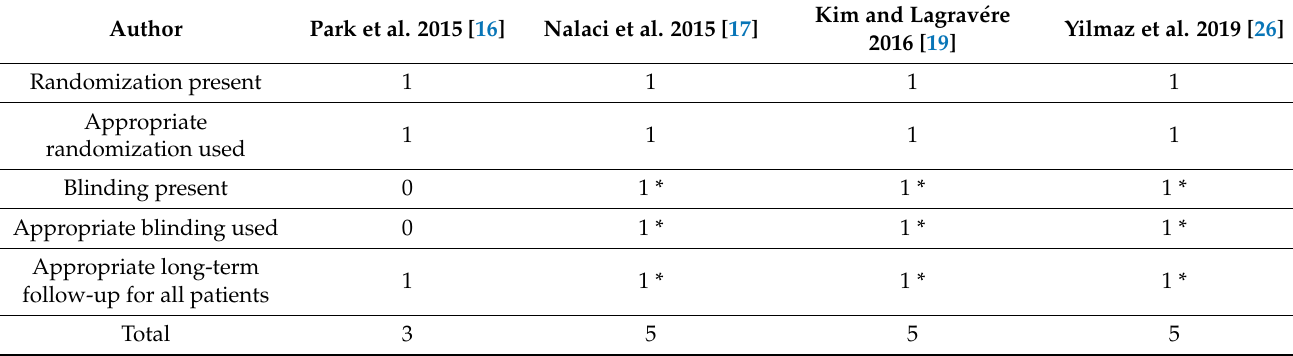
Table 2. Evaluation of included RCTs according to Jadad